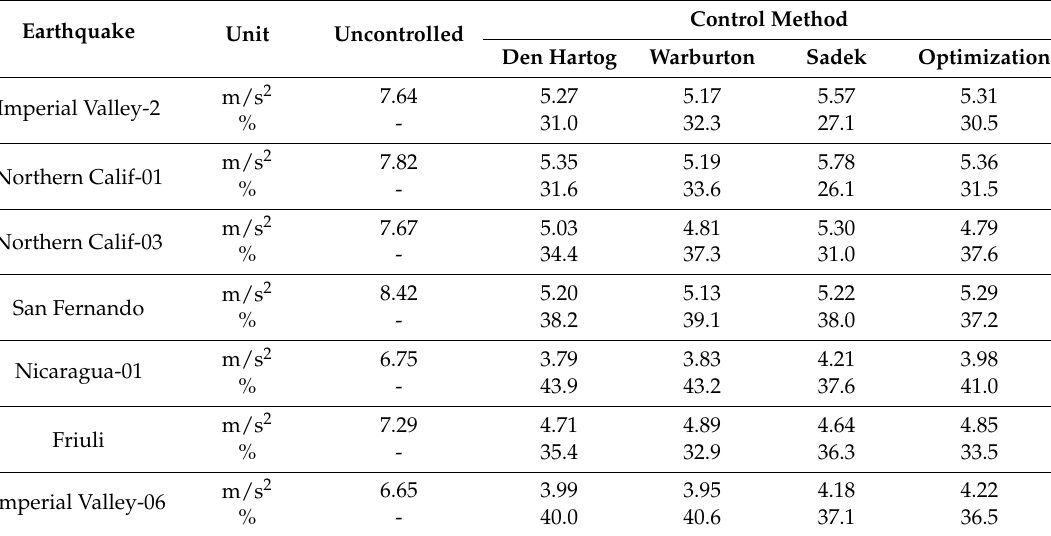
Table 7. Maximum acceleration in each earthquake case.